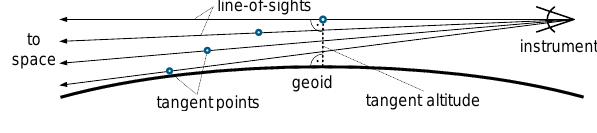
Fig. 1. A simple schematic of the measurement geometry of